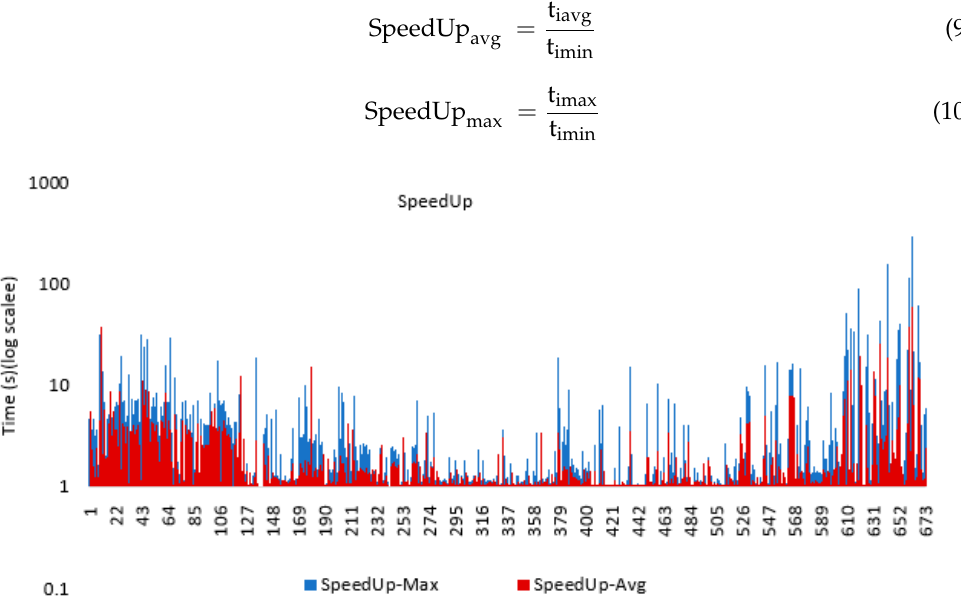
Figure 7. Speedup row sorted dataset (min to max).